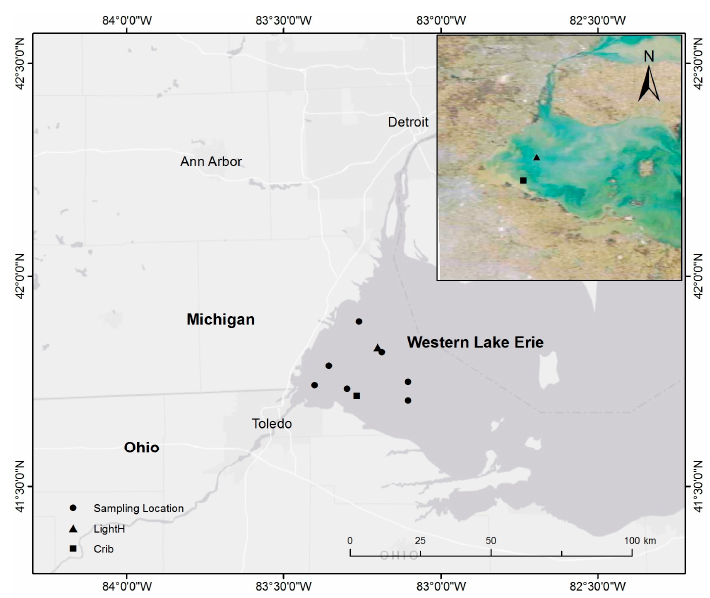
Figure 1. The study area: western Lake Erie. The two eddy-covariance (EC) towers are marked with a black triangle and a rectangle for the Light House (LightH) site and Crib site, respectively. The black circles represent the locations where water samples were taken for chlorophyll-a extraction at 10–14 day intervals. A MODIS true color image shows the highly turbid water (the top-right) in western Lake Erie. The Crib site is more turbid than the LightH site because it is closer to the mouth of the Maumee River and the shore.